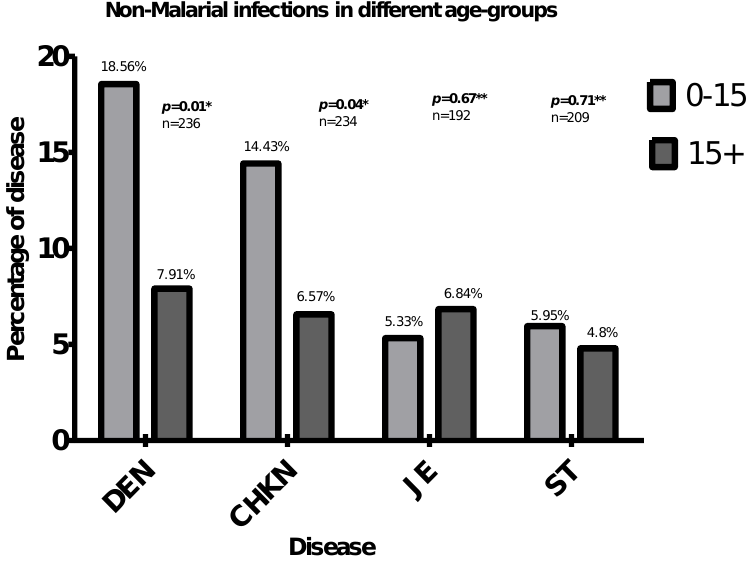
Figure 3. Age group-wise disease positivity percentage of different diseases including mixed infections. It shows significantly more risk of DEN in the lower age group. Both DEN and CHKN show higher risk in the older age group when mixed infections are considered. DEN = Dengue, CHKN = Chikungunya, JE = Japanese Encephalitis, ST = Scrub Typhus. * Statistically significant; ** Statistically not significant. Table 3. LLIN coverage and compliance pattern among tested and positive cases from villages. N denotes no. of persons, % in parenthesis represents LLINs use under different net